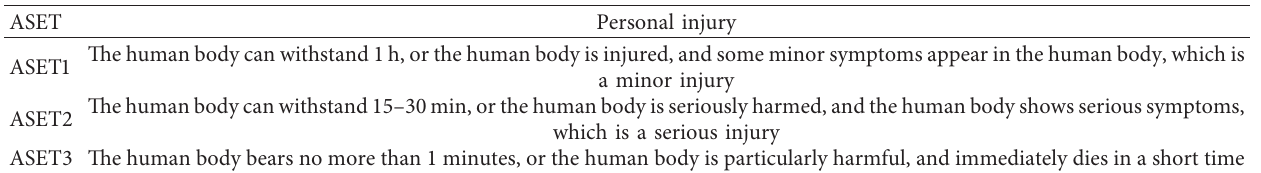
Table 10: ASET judgment index.